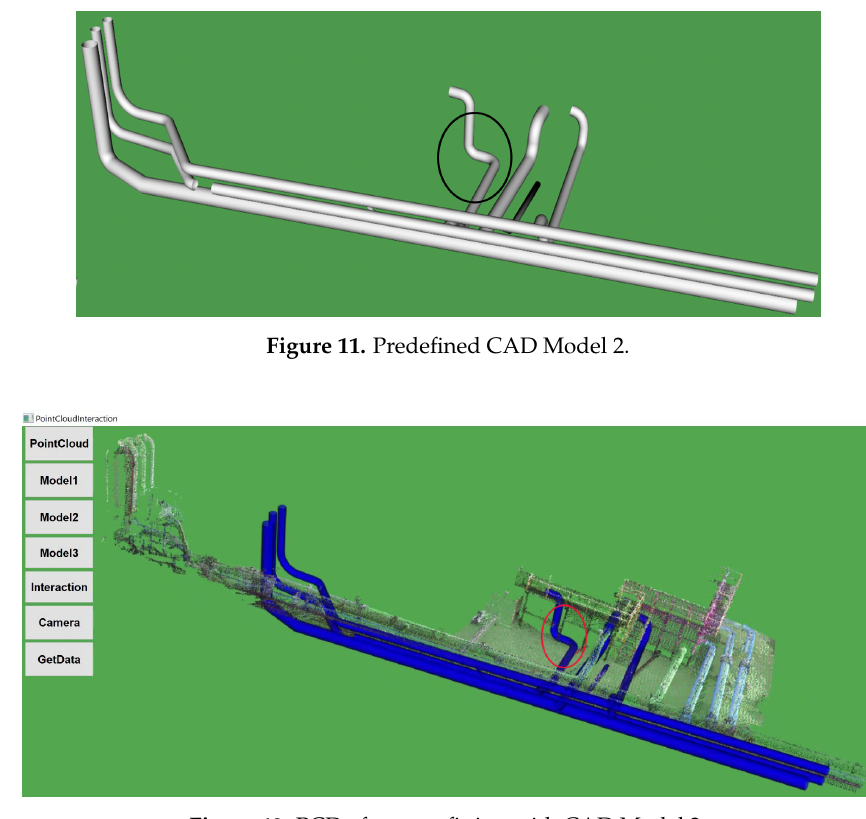
Figure 12. PCD after retrofitting with CAD Model 2.